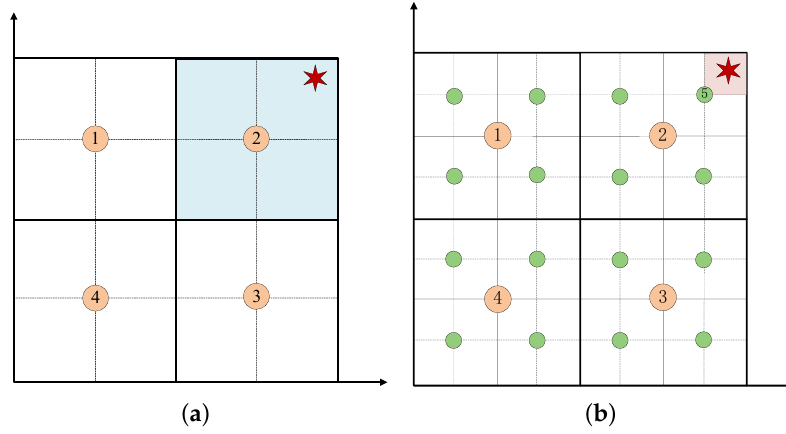
Figure 5. Node distribution and regional division. ( a ) Case 1. ( b ) Case